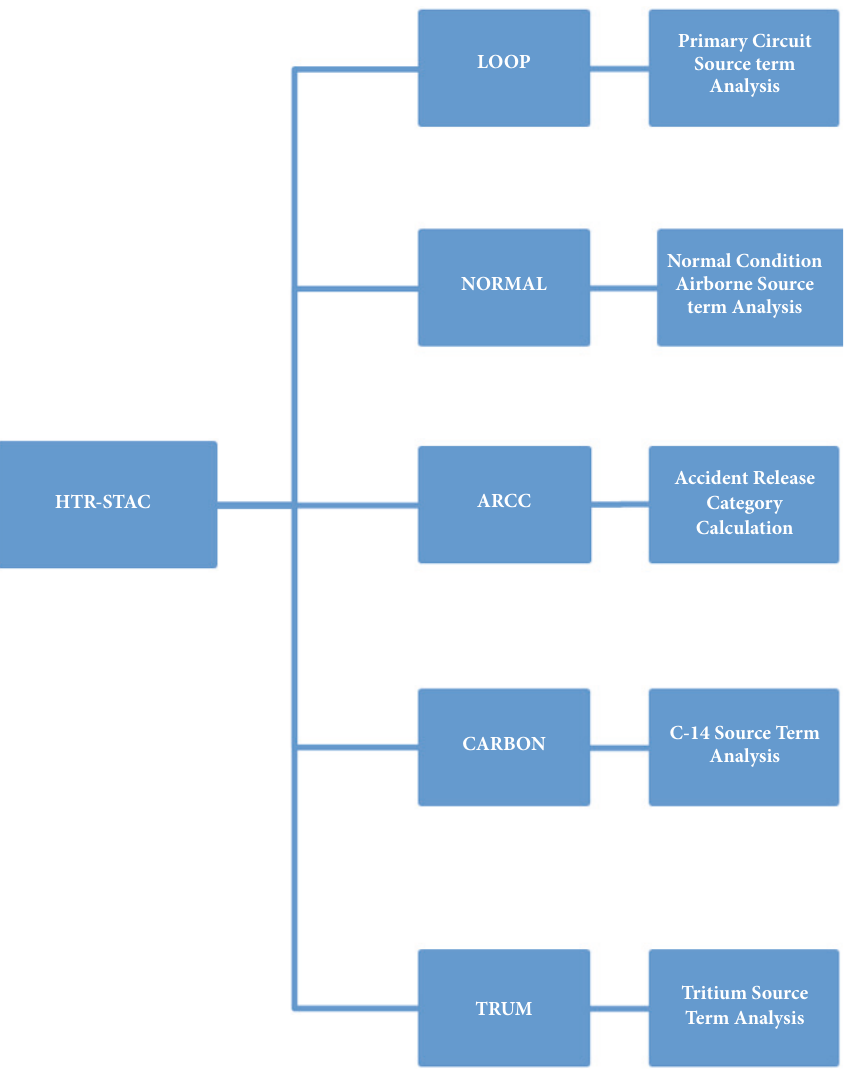
Figure 4: Construction of